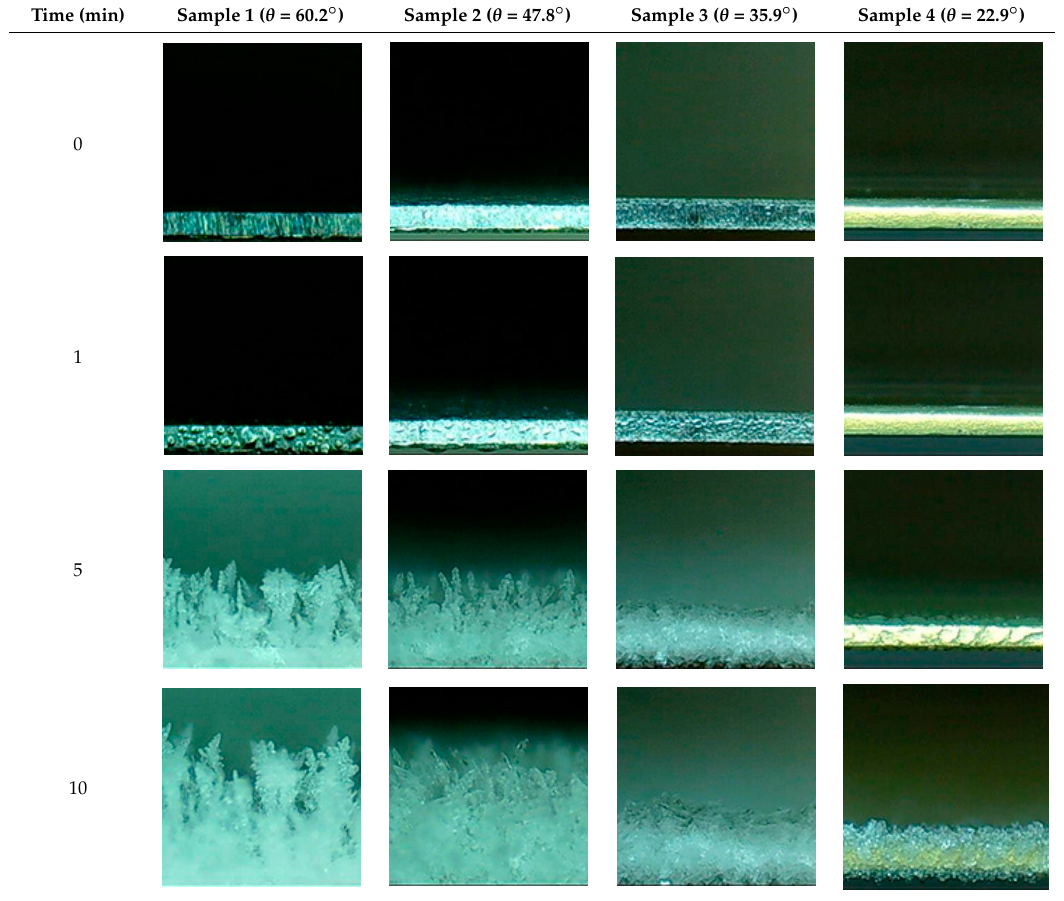
Table 5. The structure of the frost layer on the side of the aluminum sheets at T s = − 15 ◦ C, T a = 5 ◦ C, and ϕ = 60%.